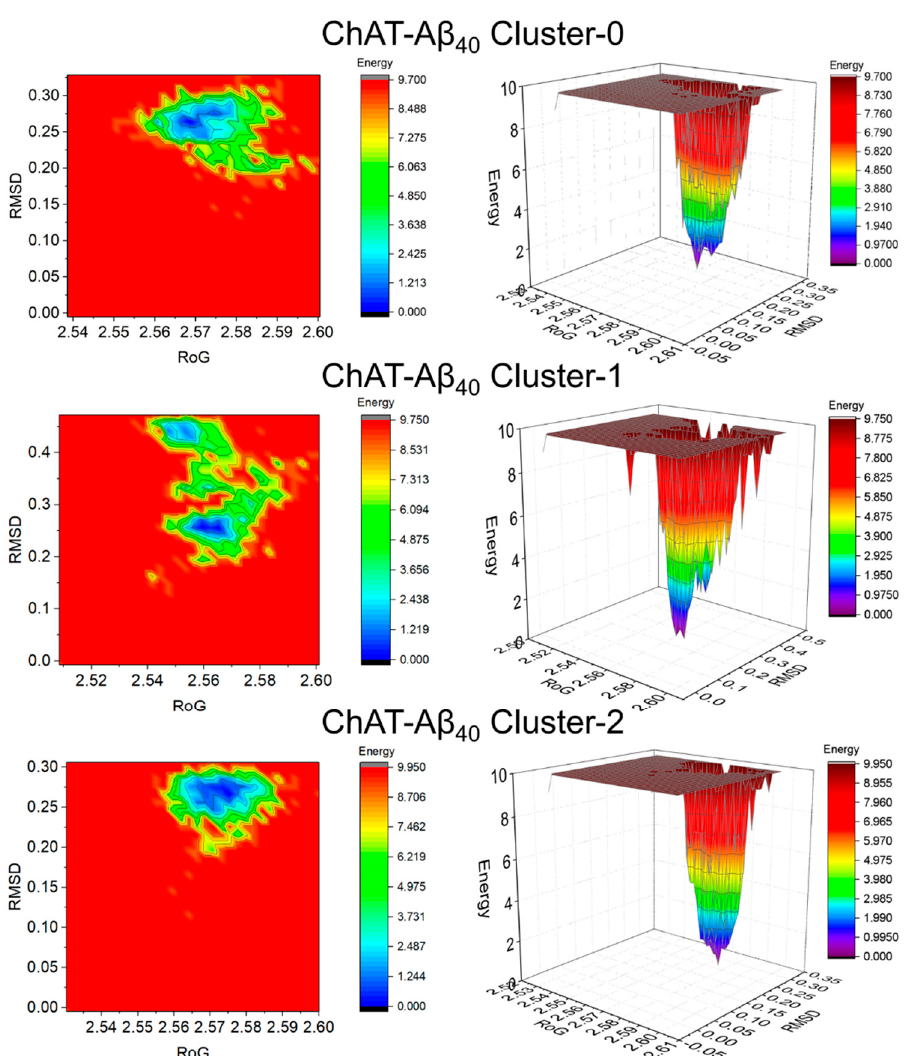
Figure 7. The 2D and 3D free-energy landscape diagrams as a function of RMSD and RoG as the two reaction coordinates of ChAT-A β 40 clusters. The free energy is given in kJ/mol and indicated by color. The folding funnel of the complex system into a single narrow funnel indicate a stable folding process. The 2D contour plots and the 3D projections were plotted using OriginPro 2017 software (OriginLab Inc., Northampton, MA, USA). RMSD: Root mean square deviation, RoG: Radius of gyration.